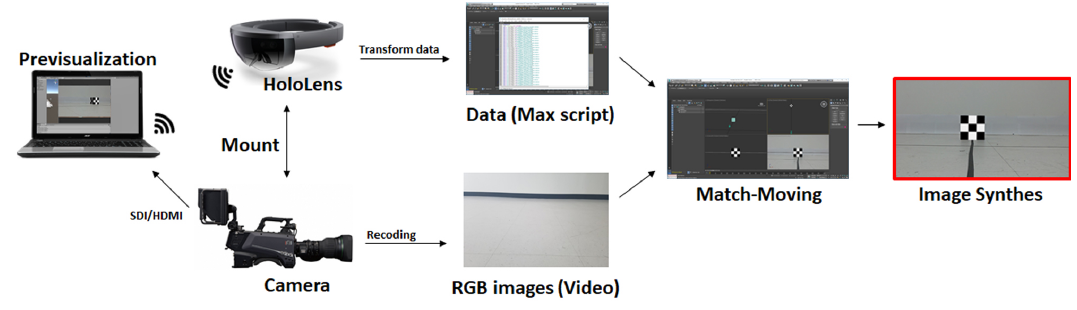
Figure 3. Novel system for real-time match-moving and pre-visualization with HoloLens.